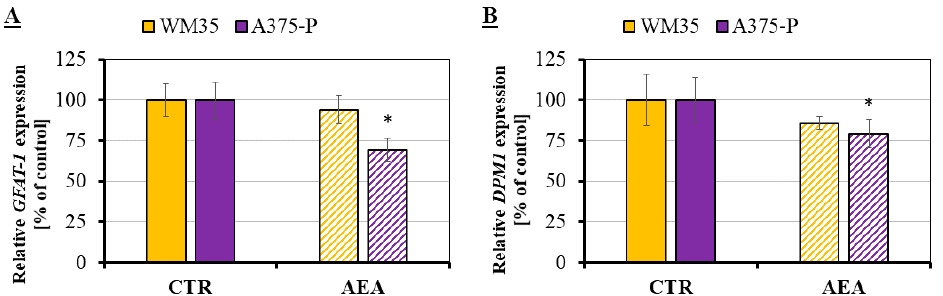
Figure 3. RT-qPCR analysis of GFAT-1 ( A ) and DPM1 ( B ) expression in AEA-treated melanoma cells. The investigated cell lines are from the following stages of melanoma progression: RGP site (WM35—yellow) and from the solid tumor site (A375-P—violet). The statistical significance of the p -value below 0.05 (*) was marked on the graph.